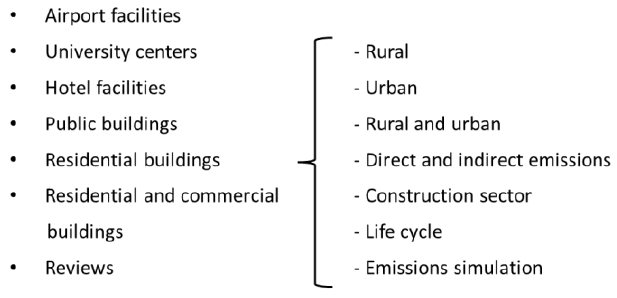
Figure 1. Grouping of research papers according to